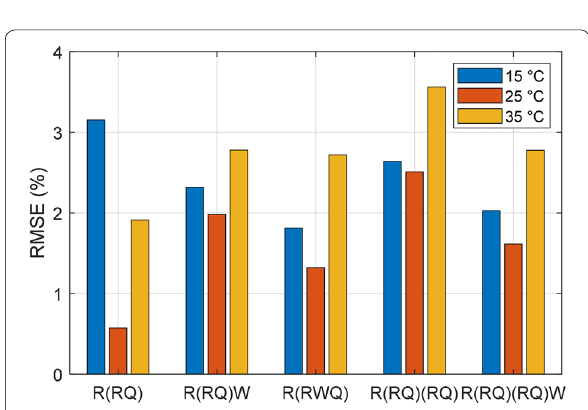
Figure 11 RMSE under different temperatures